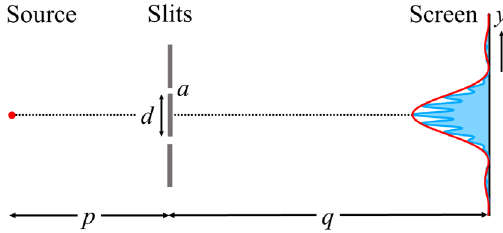
FIG. 5. Schematic of a double-slit interferometry